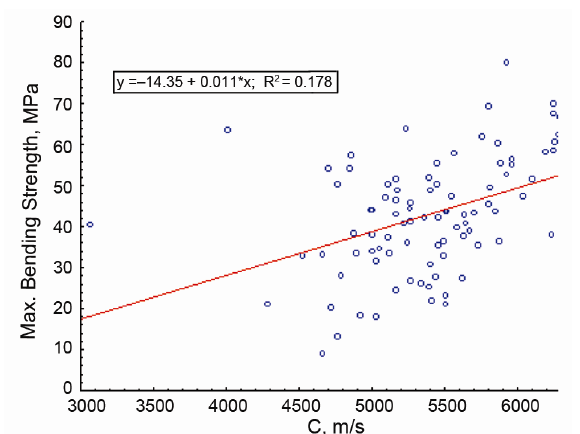
Fig. 6. Relation between modulus of elasticity and B (indirect measurement with a spacing of 600 mm on the tangential sur- face)